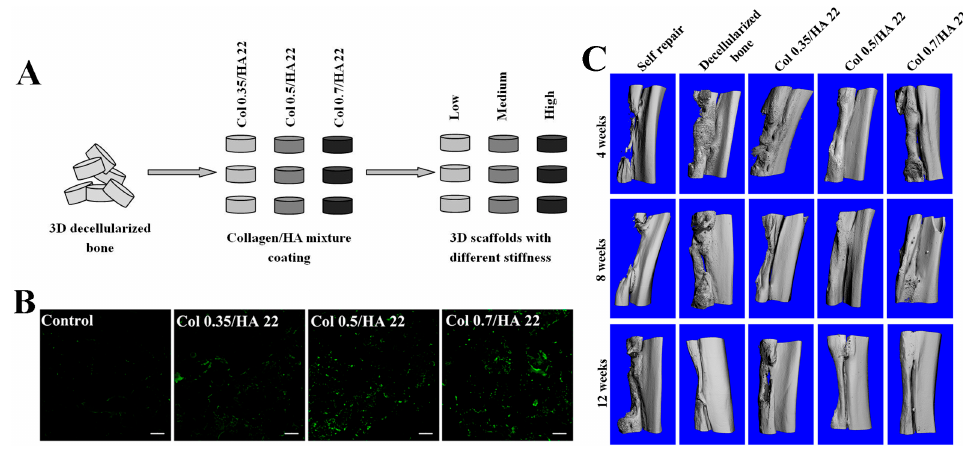
Figure 1. Fabrication of collagen/hydroxyapatite (HA) scaffolds and their application of bone repair. ( A ) Schematic diagram of the fabrication process of 3D scaffolds with different stiffness. Reprinted from [106]. Copyright 2015 with permission from American Chemical Society. ( B ) immunofluorescence staining of collagen type I on the scaffolds; scale bar: 200 µ m. Reprinted from [106]. Copyright 2015 with permission from American Chemical Society. ( C ) µ -CT images of segmental radius at 4, 8 and 12 weeks [107]. Copyright 2015 with permission from